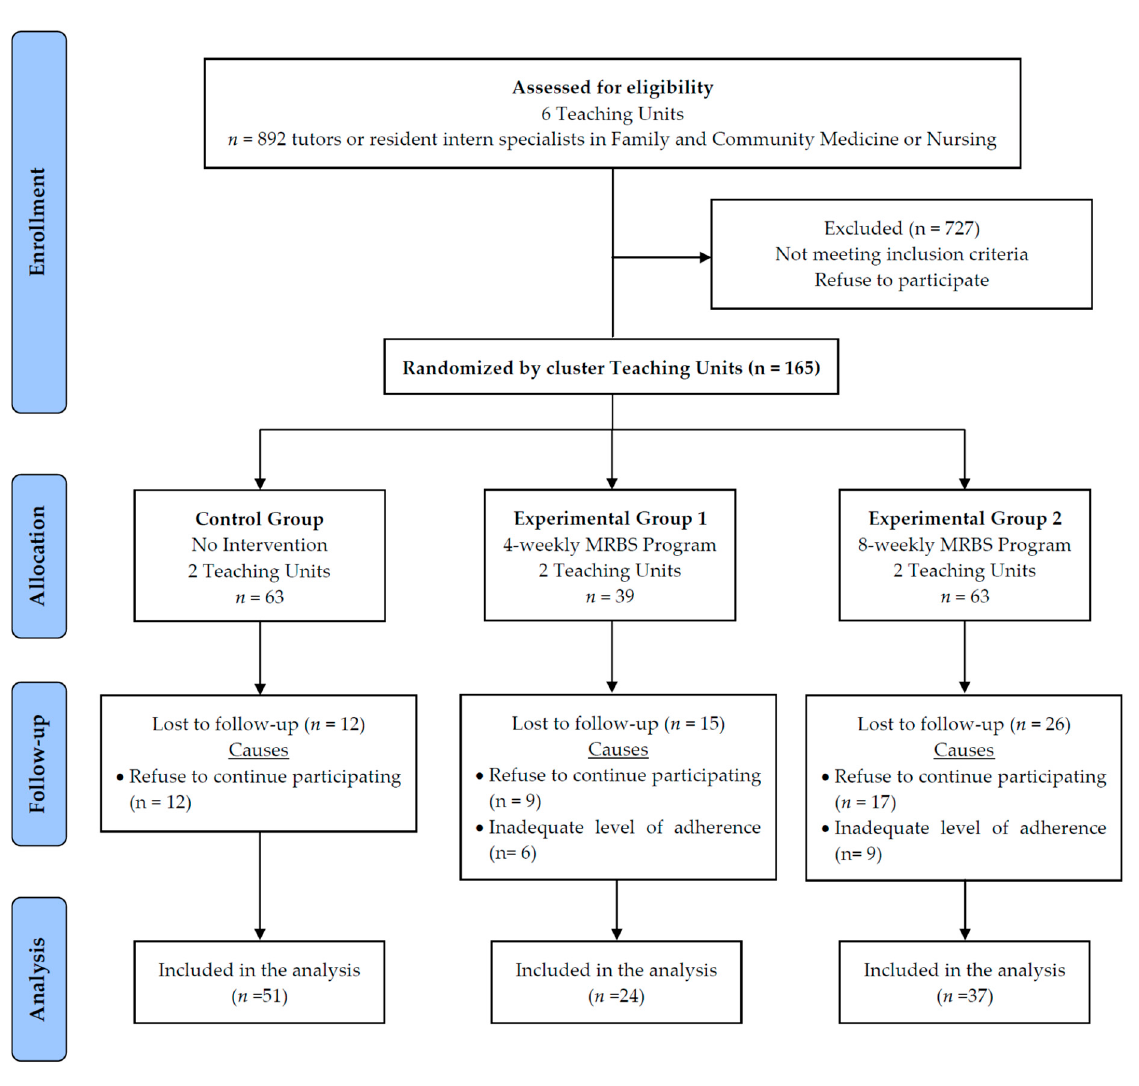
Figure 1. Flow chart of participants through the study.